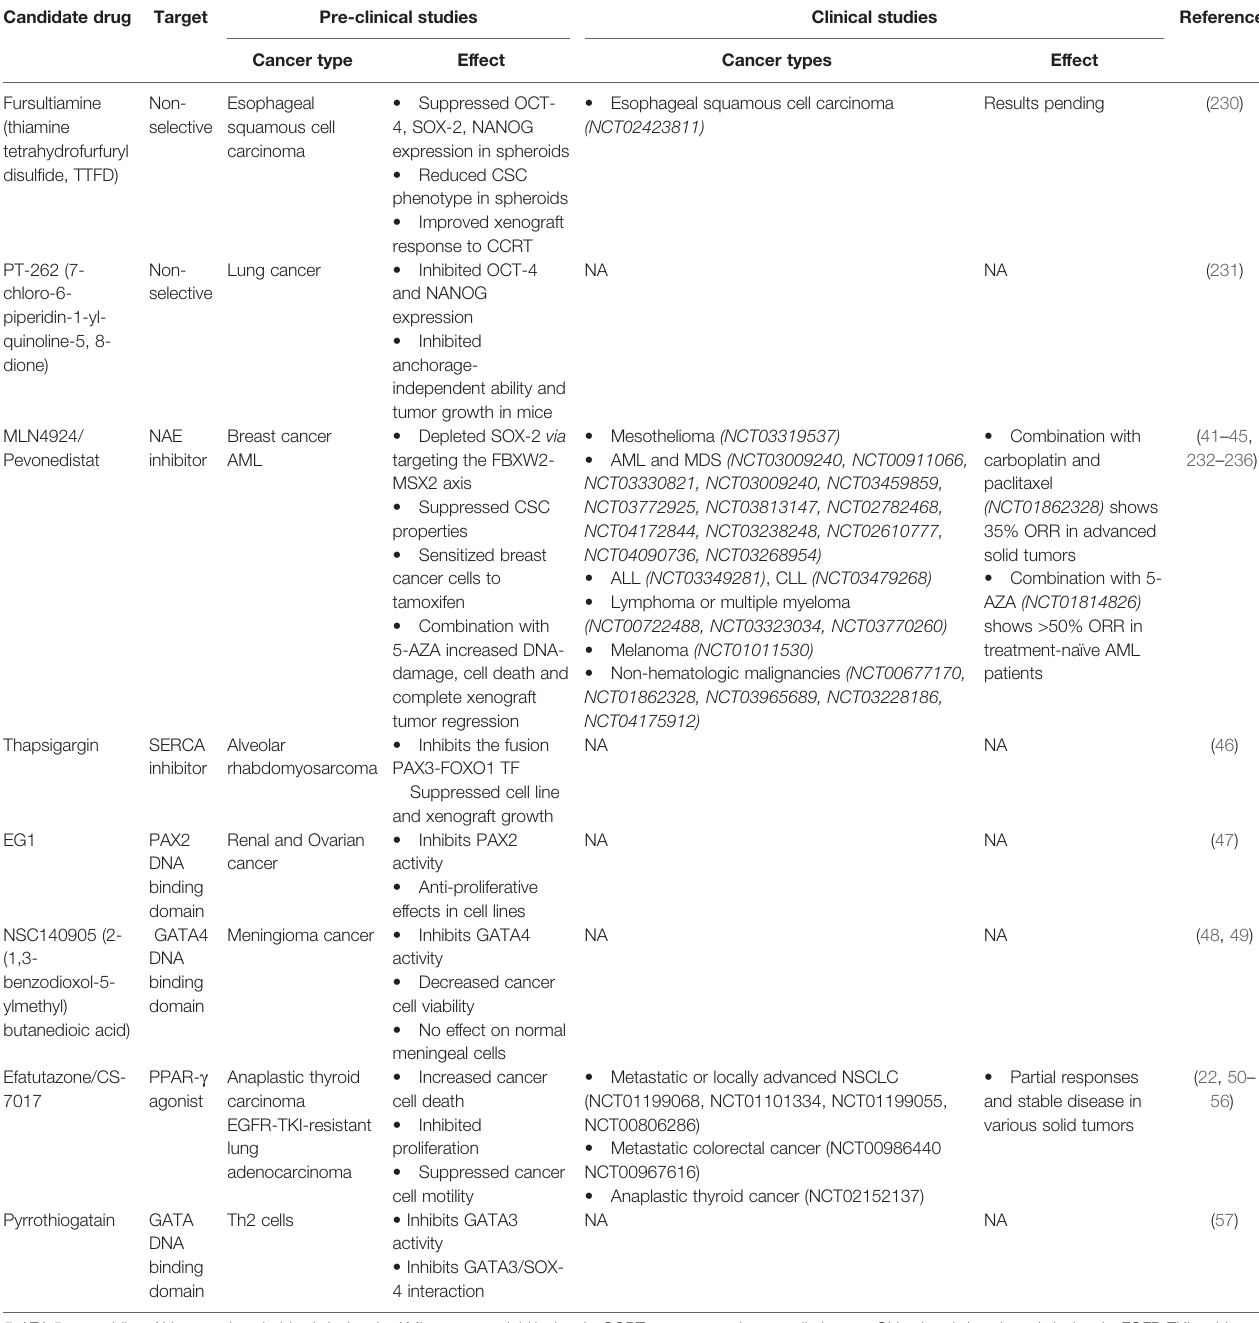
TABLE 3 | Inhibitors of cancer stem cell transcription